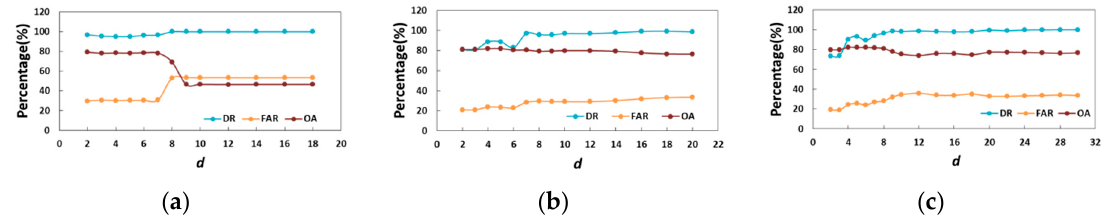
Figure 4. Discussion of the d experiment, ( a ) is the result of F1 dataset, ( b )is F2 dataset, ( c )is F3 dataset.